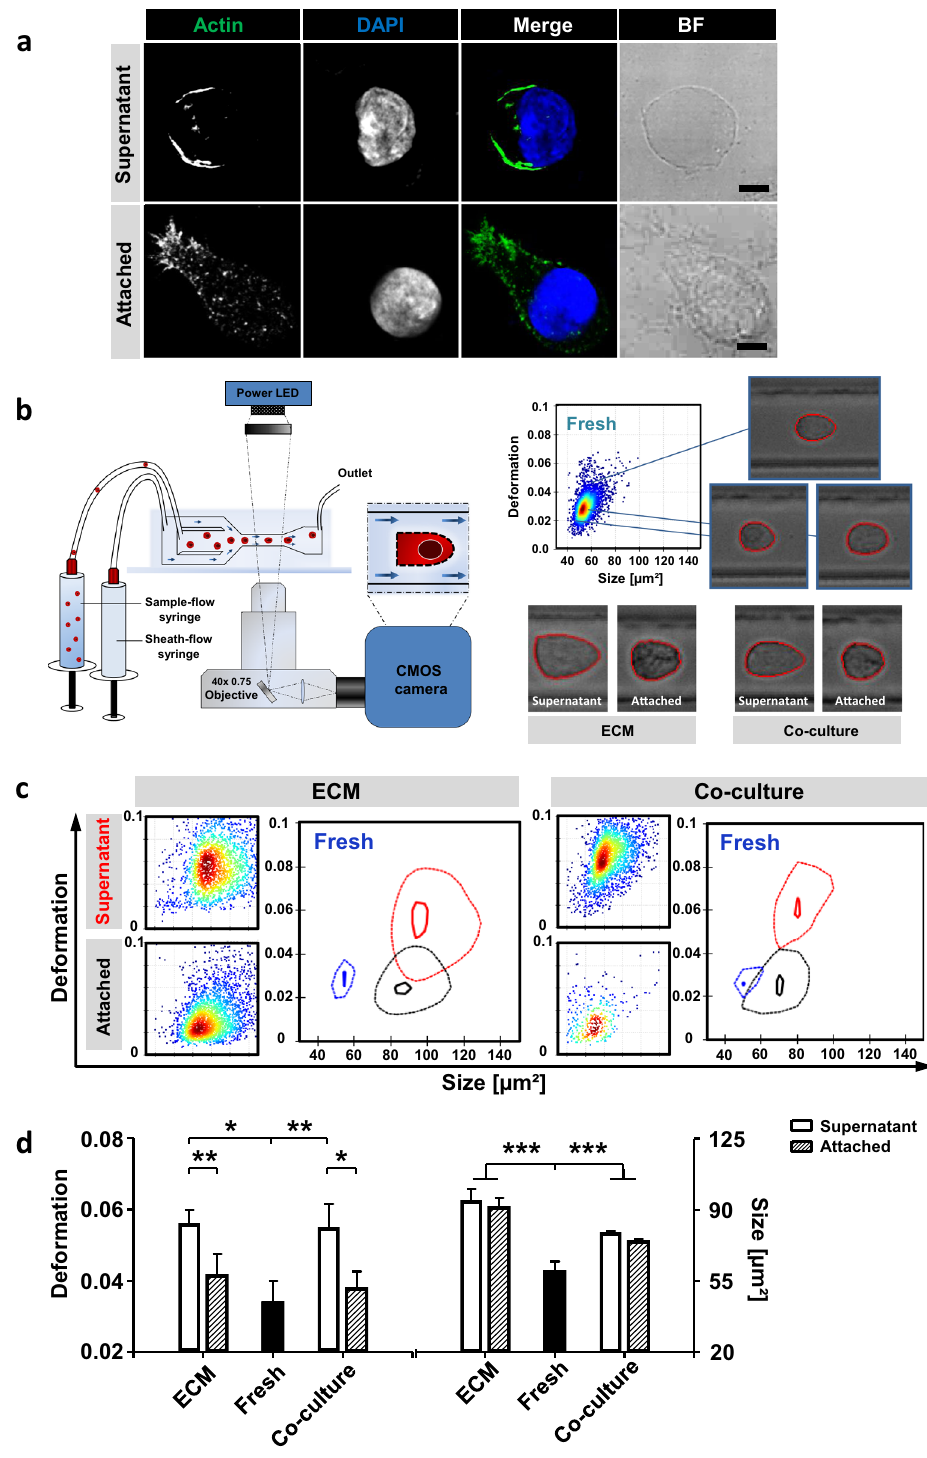
Figure 2. HSPC adhesion to ECM-proteins remodel morphological and mechanical phenotype. ( a ) Confocal microscopy single z-slice images of actin cytoskeleton using phalloidin-488 (green) staining and nuclei DAPI (blue) staining. Bars = 5 µ m. ( b ) Schema shows an overview of RT-DC set-up. Representative heat-plot of RT-DC measurement was recorded directly after MACS isolation of fresh CD34 + cells. Representative images of cells in microfluidic channel constriction of fresh, ECM or MSC co-cultured cells. ( c ) Representative heat- plots of cell-size and cell-deformation of AT- and SN-cells either ECM- or MSC co-cultured. Contour-plots compare freshly isolated cells (blue), AT-cells (black) and SN-cells (red). The solid inner line highlights 95% and the dashed outer line 50% density. Cells measured after a 5 day cultivation period. ( d ) Statistical analyses of deformation and cell-size measured in RT-DC of fresh cells and ECM- or MSC co-cultured cells. n = 5, linear mixed model analysis, Error bars, SD.; * p < 0.05, ** p < 0.01, *** p <